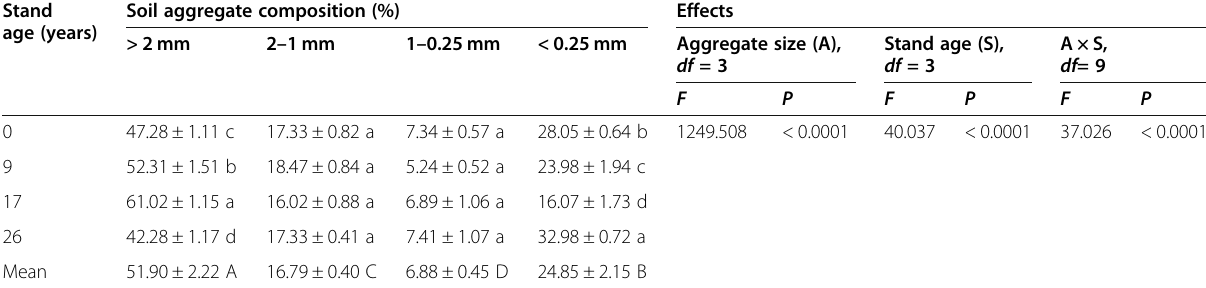
Table 2 Effects of aggregate sizes (> 2, 2 – 1, 1 – 0.25, and < 0.25 mm) and stand ages (0, 9, 17, and 26 years old) on the soil aggregate composition in a chronosequence of Chinese fir plantations Stand Soil aggregate composition (%) age (years)